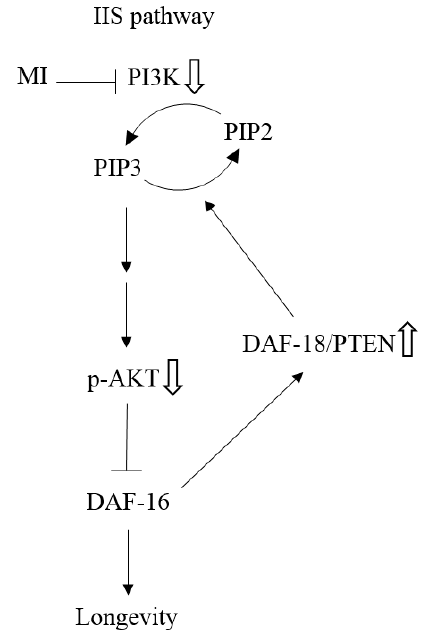
Figure 9. The schematic presentation of the mechanisms by which MI inhibits the signaling of insu- lin/insulin-like growth factor 1 (IIS) pathway. The symbol as: “The inhibition step of MI or the inactivation step in the signaling pathway”, the symbol as “The detected downregulation of protein expressions or protein phosphorylation by MI”, and as “The detected upregulation of protein expression by MI” in this study. NB: the references are indicated in square brackets.